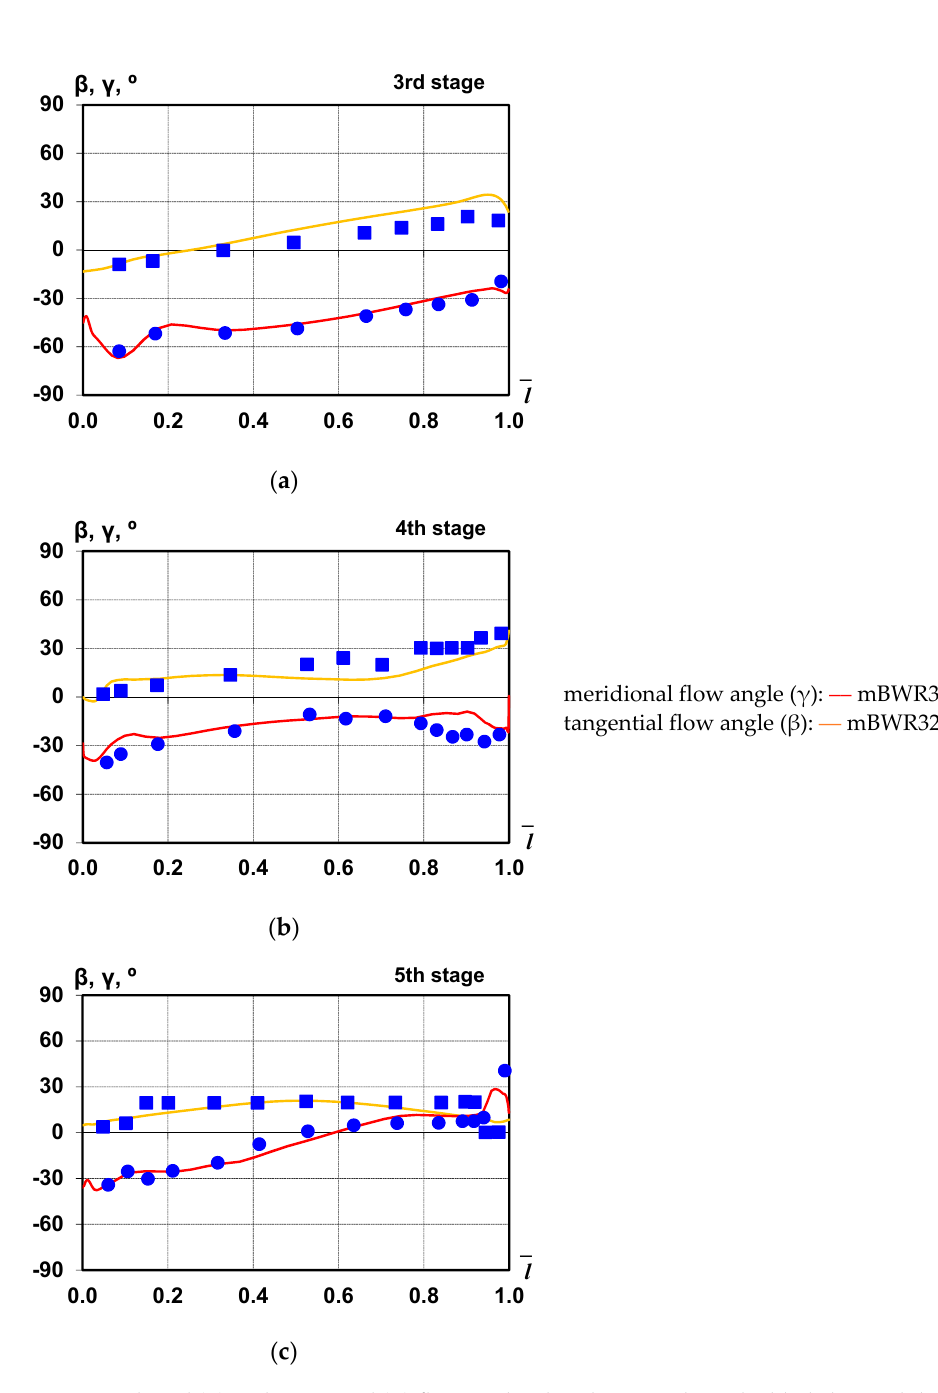
Figure 3. Meridional ( γ ) and tangential ( β ) flow angles distributions along the blade beyond the third ( a ), fourth ( b ), and fifth ( c ) stages.